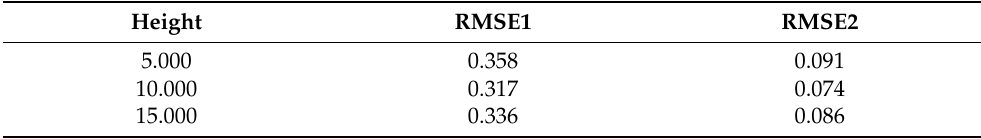
Table 1. Error analysis of planes with different heights